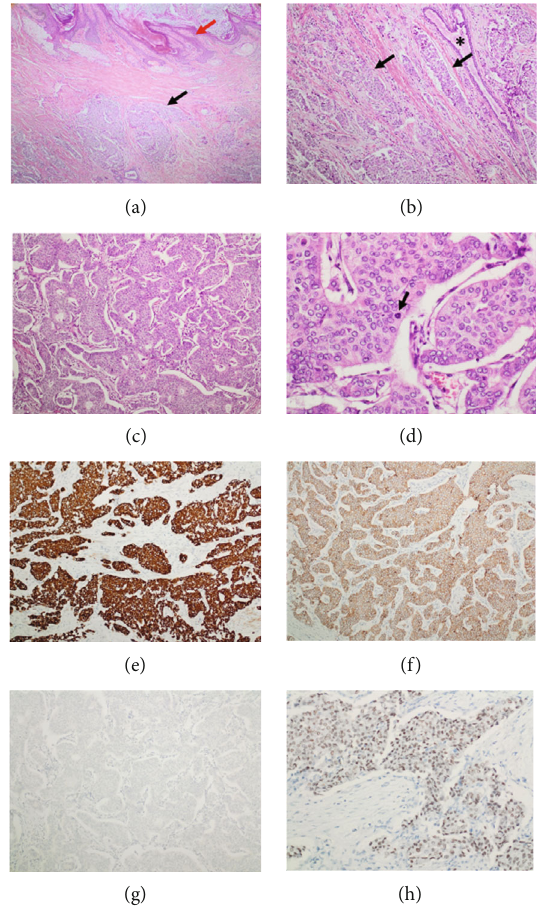
Figure 5: Representative hematoxylin and eosin (H and E) staining and immunohistochemistry staining of male breast cancer. (a) Invasive carcinoma (black arrow) can be seen immediately below the skin of the nipple (red arrow), with no evidence of skin invasion; magni fi cation, × 40. (b) In fi ltrating nests of tumor cells (arrow) surrounded by desmoplastic stroma. The asterisk indicates the entrapped normal duct; magni fi cation, × 100. (c) Invasive ductal carcinoma composed of malignant cells arranged in sheets and nests; magni fi cation, × 100. (d) High-power view showing malignant cells with intermediate-grade nuclei that exhibit mild to moderate pleomorphism, open vesicular nuclei, and punctate nucleoli. Frequent mitotic fi gures were also seen (arrow); magni fi cation, × 400. (e) Staining for pancytokeratin exhibited di ff use positivity; magni fi cation, × 100. (f) E-cadherin expression exhibited a membranous staining pattern on H and E staining; magni fi cation, × 100. (g) P63 was completely negative, which indicates loss of the myoepithelial layer and con fi rms the invasive nature of the tumor; magni fi cation, × 100. (h) Estrogen receptor staining exhibited intermediate to strong nuclear positivity in > 90% of tumor cells; magni fi cation, ×